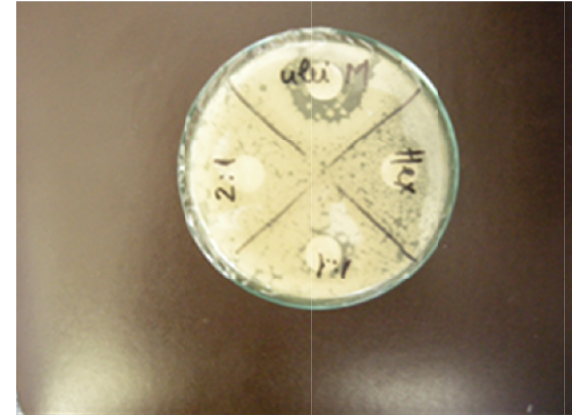
Fig. 3. Diameters of the inhibiting zones at Diameters of the inhibiting zones at